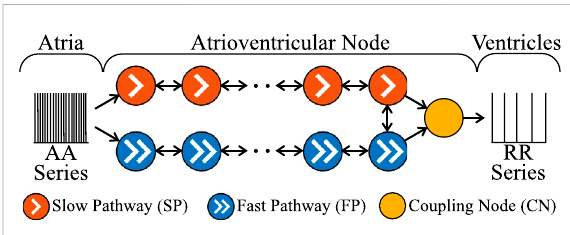
FIGURE 1 A schematic representation of the AV node model. Note that retrograde conduction is possible within the AV node model. For